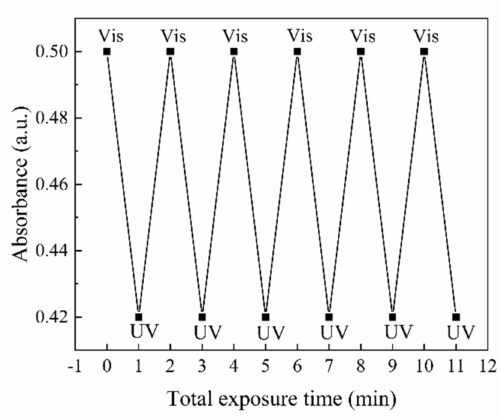
Figure 8. Optical switching characteristics of the composite films by alternating UV and visible light irradiation for five cycles (light intensity, UV: 16 mW/cm 2 , vis: 12 mW/cm 2